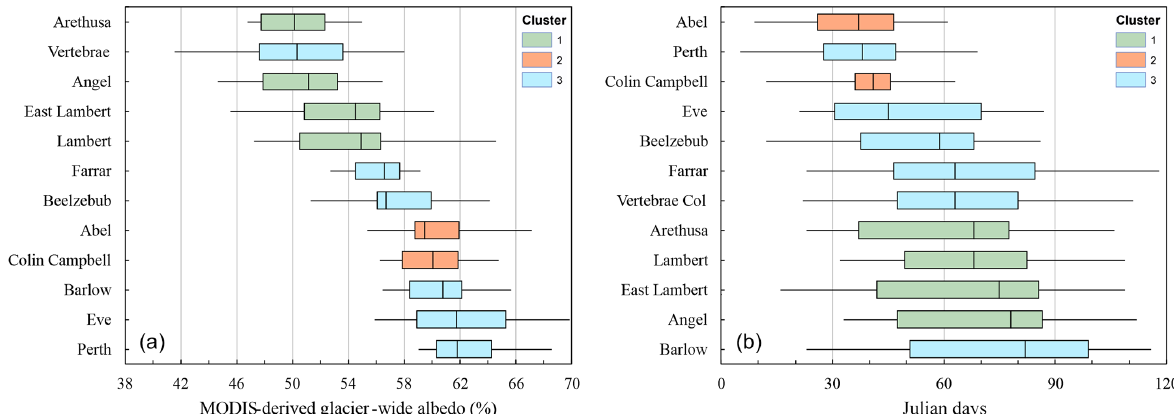
Figure 6. The (a) magnitude and (b) timing of the ¯ α min yr over the 12 outlet glaciers of the GoEA between 2000 and 2018. The box plots represent the 19-year median, minimum, maximum and interquartile range of each of the glaciers. Table 3. Correlation between the median timing and magnitude of the ¯ α min yr and glacier hypsometry using Spearman’s rank coefficient ( r ) for the 12 outlet glaciers of the GoEA. Two-tailed correlation is significant at the 0.05 level ( ∗ ) and the 0.01 level ( ∗∗ ). Elevation Slope Aspect Area Topographic shading (m) ( ◦ ) cos( θ ) sin( θ ) (km 2 ) (%) ¯ α min − 0 . 489 − 0 . 555 0.251 0.741 ∗∗ yr (%) 0.406 0.196 ¯ α min − 0 . yr (t) 0.049